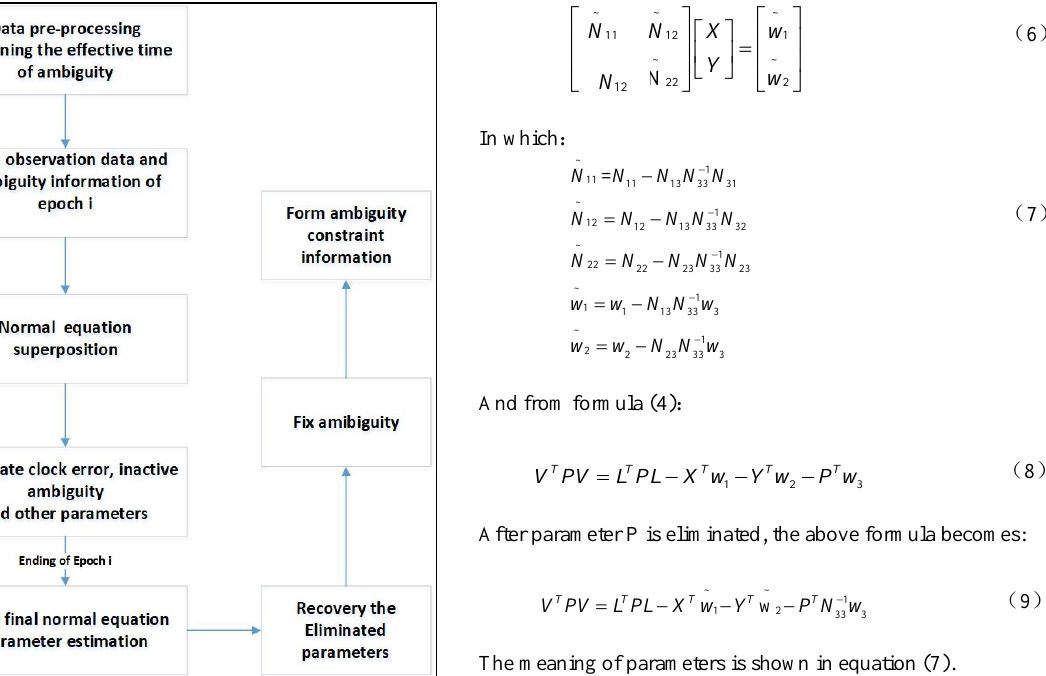
Figure 5. Parameter